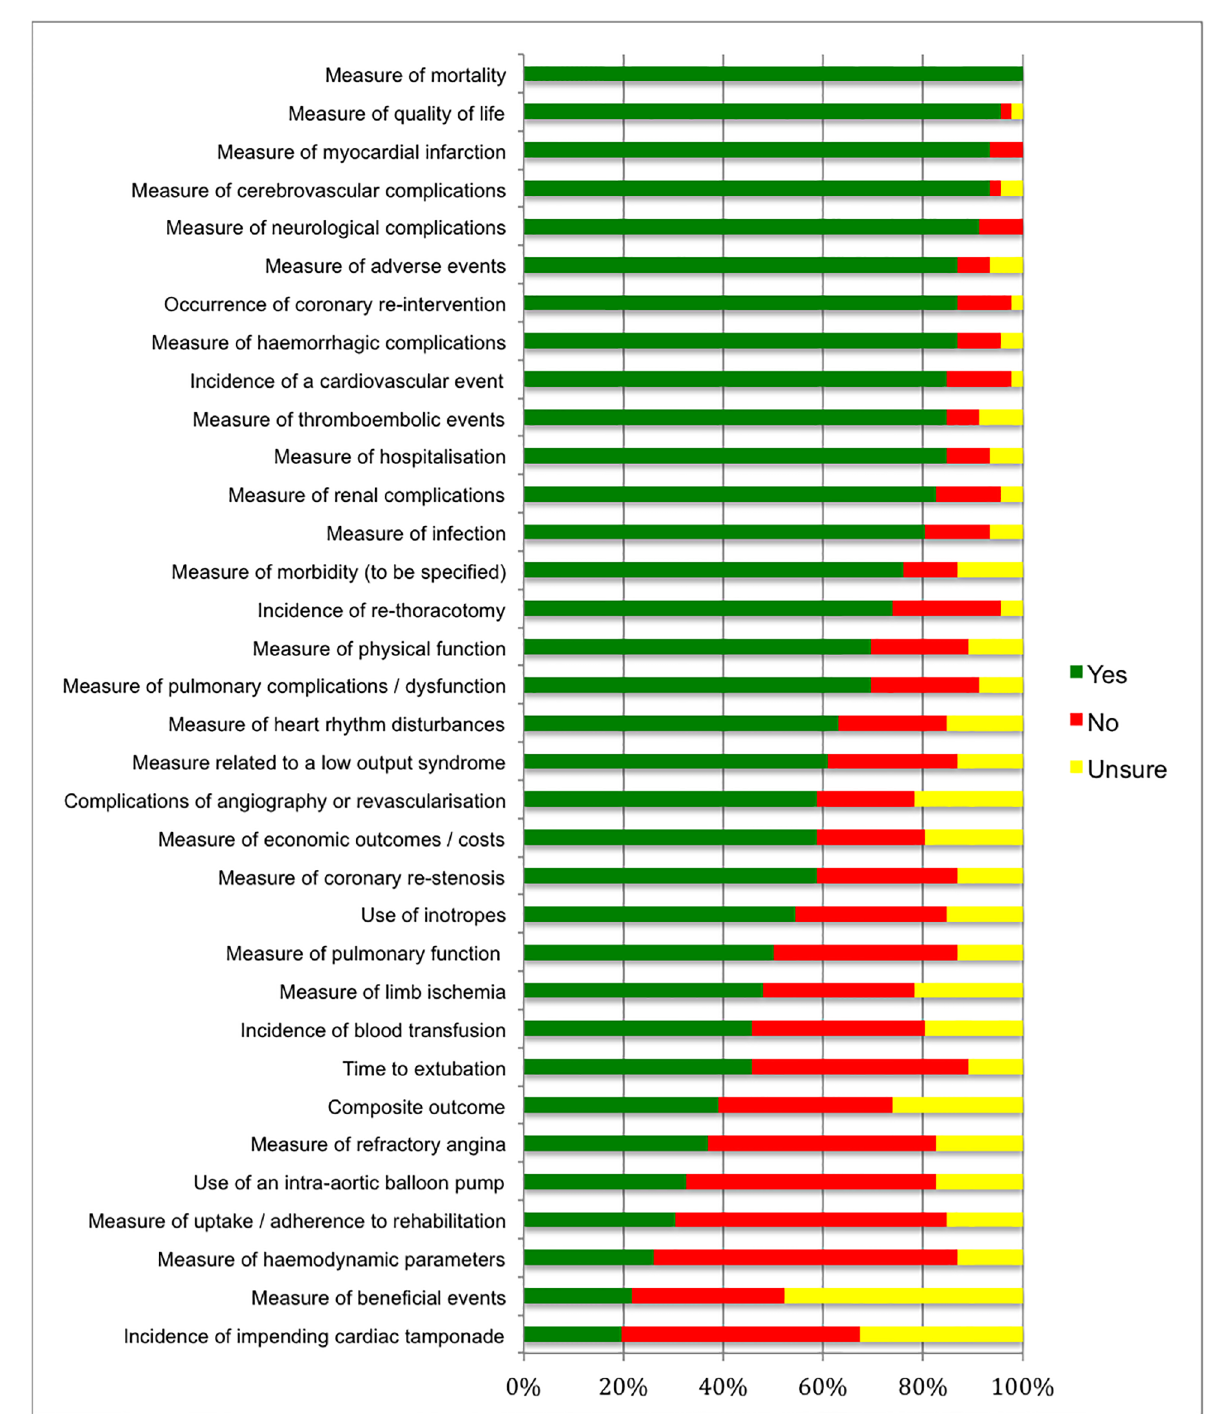
Fig 3. Round 2 of eDelphi: Rating for 34 potential core outcomes.